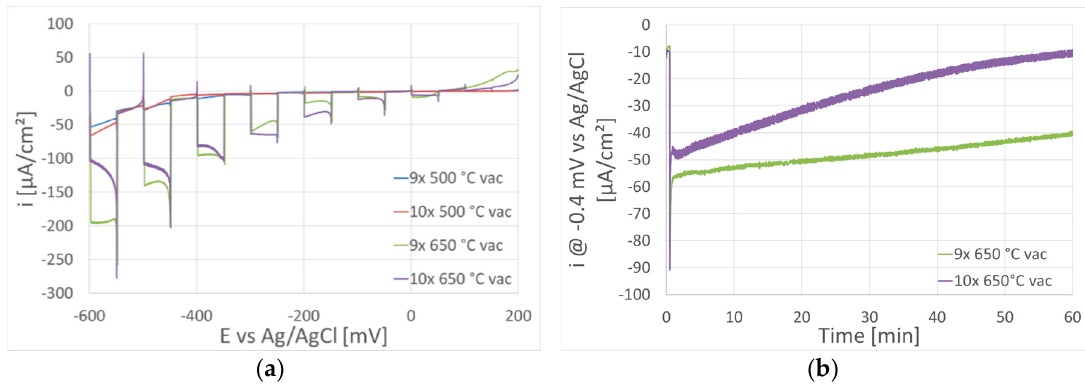
Figure 8. Linear voltammetry ( a ) and chronoamperometry ( b ) of samples 9x and 10x exposed to post deposition annealing in vacuum for 6 h at 500 °C (500 °C vac) and 650 °C (650 °C vac). Table 2. Semiquantitative XRD analysis